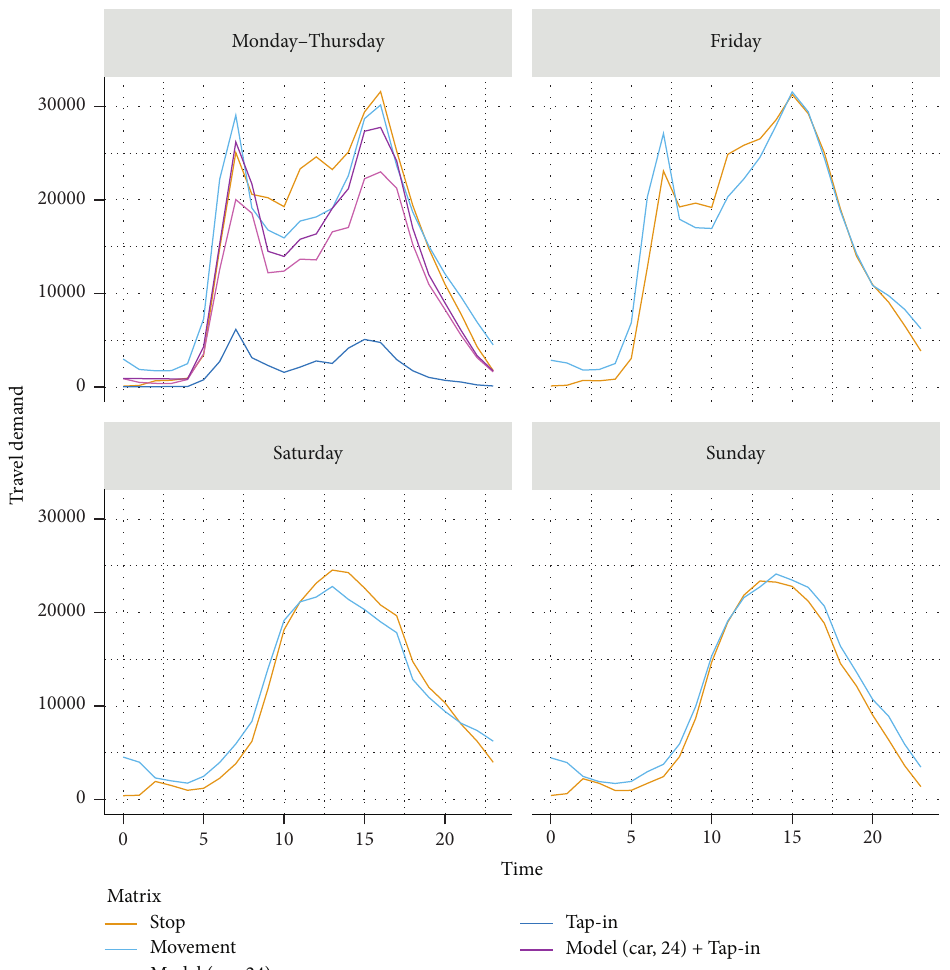
Figure 15: Time distribution of the scaled travel demand in the different OD matrices. For Monday–Thursday, an average is presented as these days show very similar